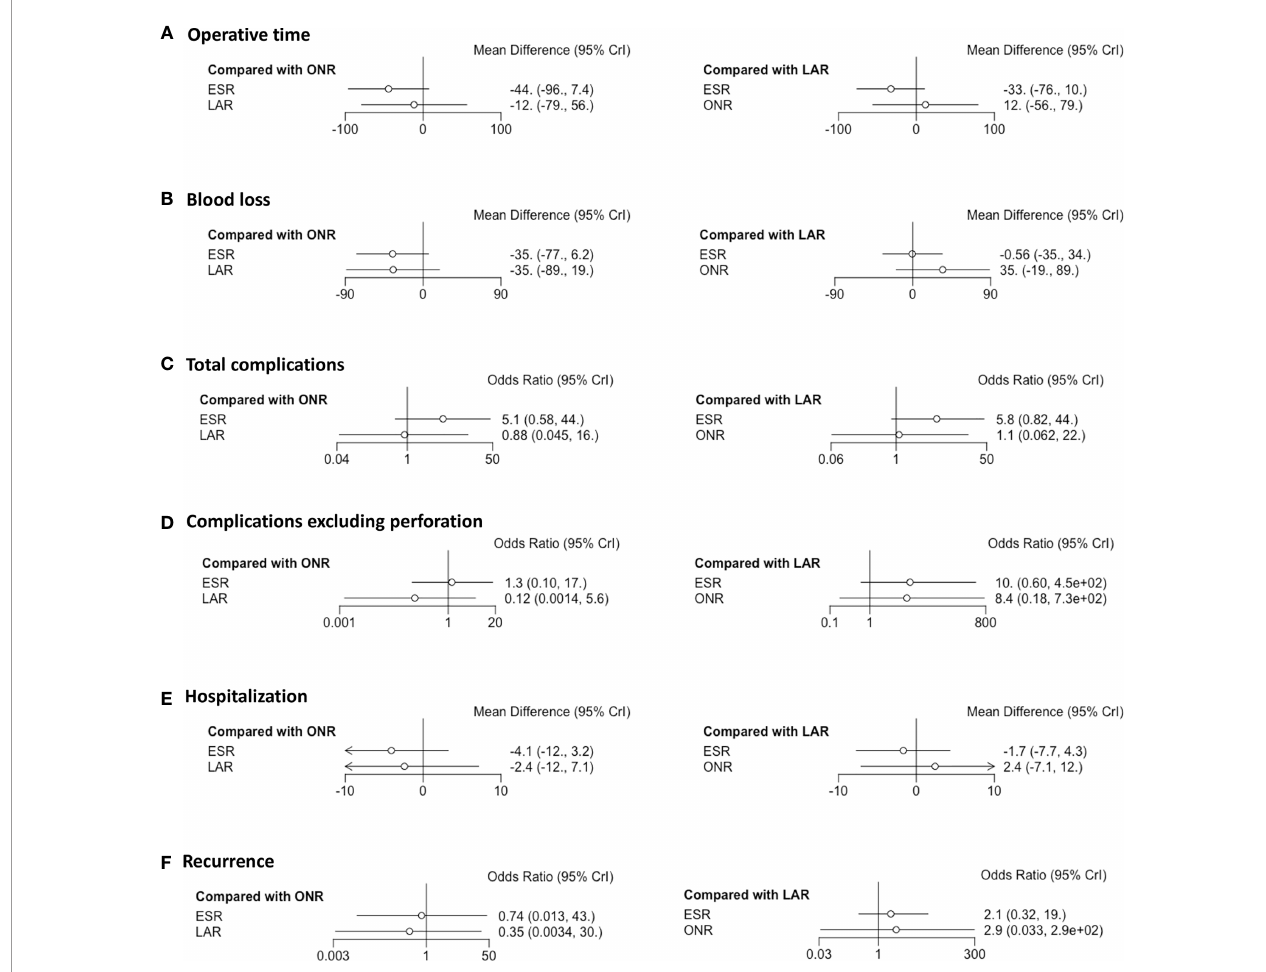
FIGURE 5 | Forest plots illustrating the results of the subgroup analysis (tumor size < 2cm). The (A) operative time, (B) intraoperative blood loss, (C) total complications, (D) complications excluding perforation, (E) hospitalization and (F) recurrence were analyzed